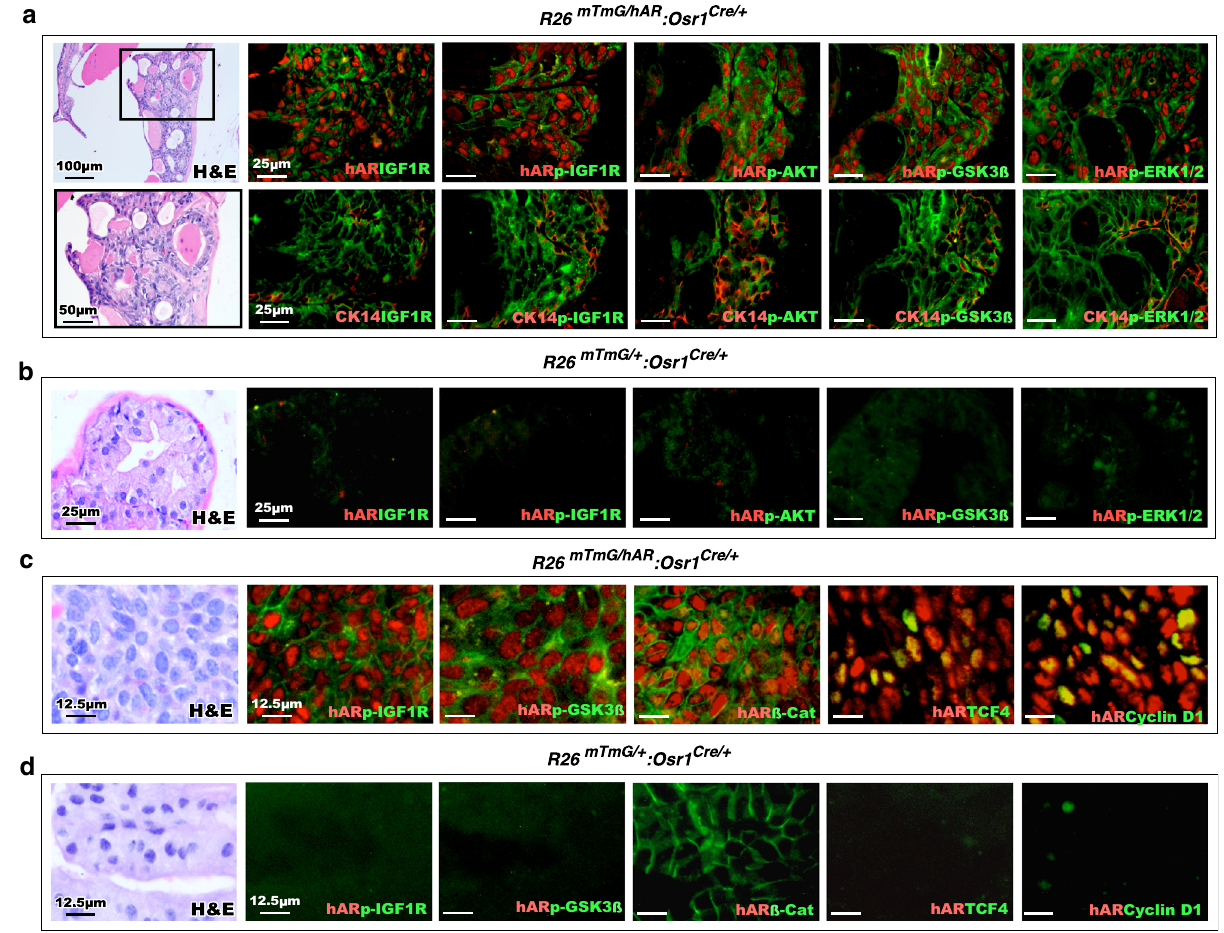
Fig. 6 | Activation of hAR transgene expression initiates PIN formation and tumor development through aberrant elevation of IGF1 and Wnt/ß-catenin signaling pathways. Representative images of H&E and co-IF staining for hAR or CK14, a basal cell marker, and IGF1 signaling downstream mediators, including IGF1R, phosphorylated-IGF1R (p-IGF1R), p-AKT, p-GSK3ß, and p-ERK1/2 in PIN tis- suesectionsfrom R26 mTmG/hAR : Osr1 Cre/+ miceat6monthsage( a )andnormalprostate tissue sections from age-matched R26 mTmG/+ : Osr1 Cre/+ wild type mice ( b ). Scale bars,